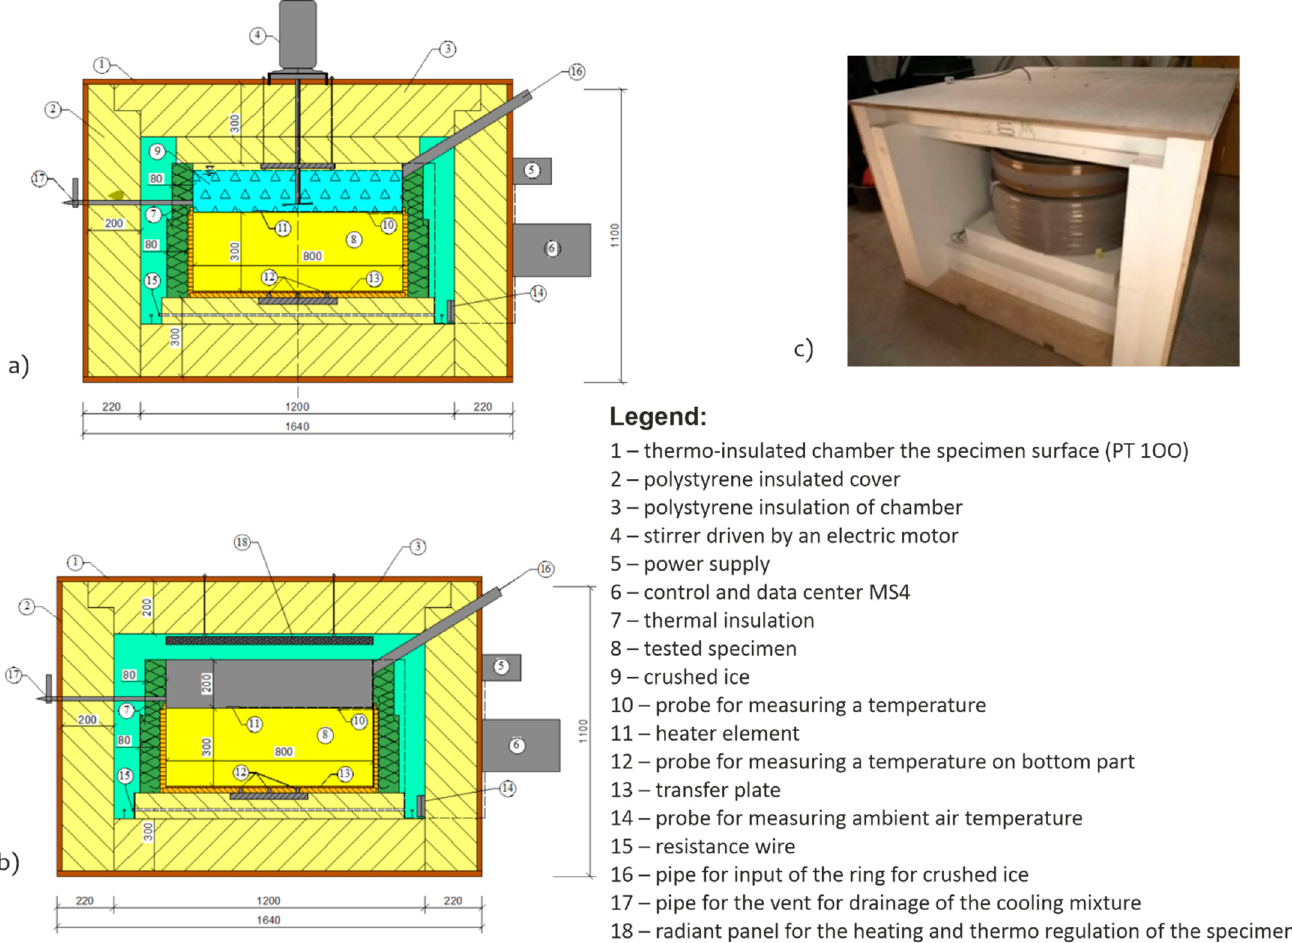
Figure 2. Device for recording the time interval of the specimen freezing, cross section of device in the mode of freezing specimen by crushed ice ( a ), cross section of device in the mode of heating ( b ), photo of device ( c ).